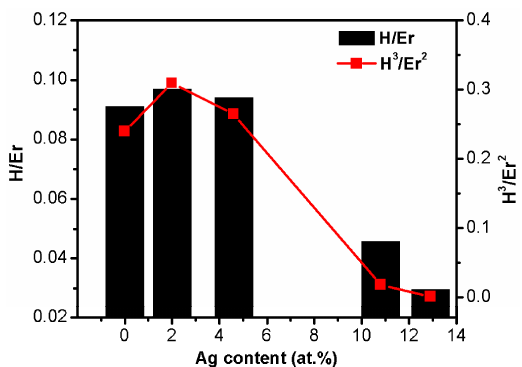
Figure 9. The ratios of H / E and H 3 / E r 2 for NbCN-Ag composite films with different Ag contents.